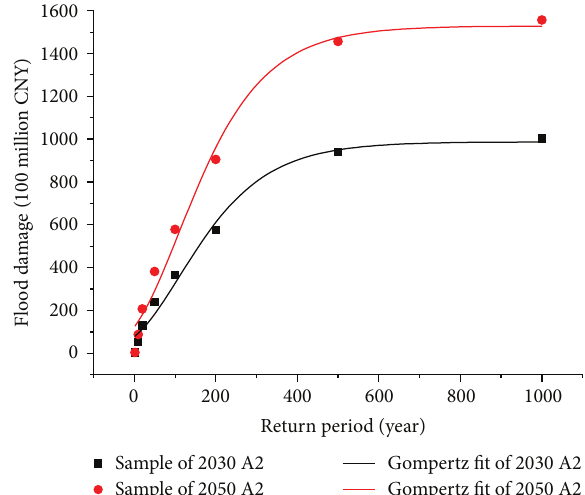
Figure 8: Gompertz function fitting results in 2030 and 2050.